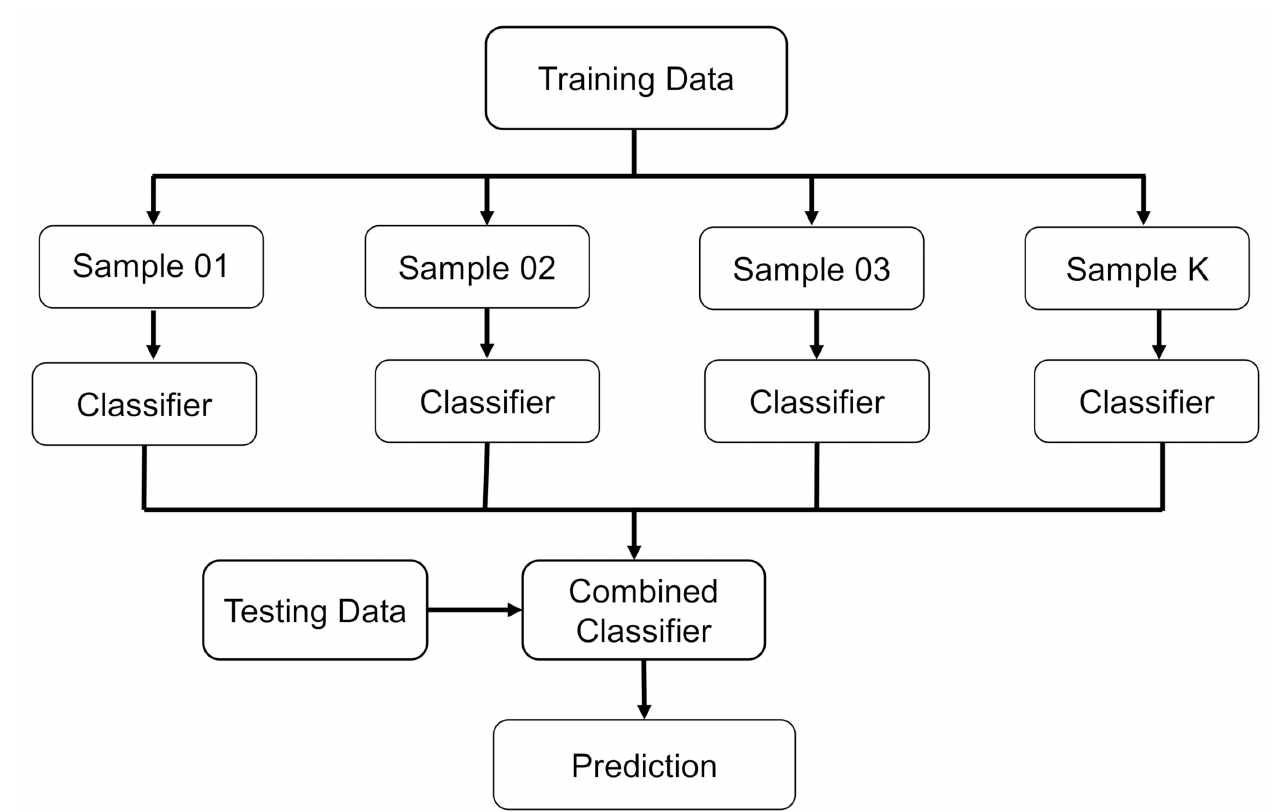
Figure 5. Schematic representation of the bagging regressor technique